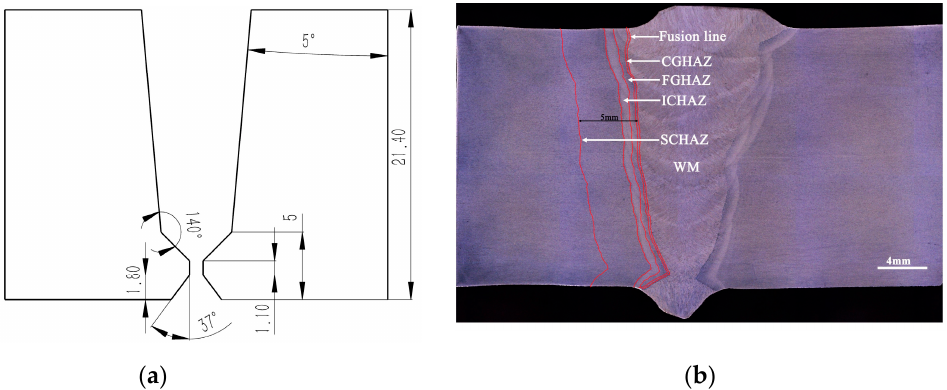
Figure 1. Macroscopic appearance of the X80 pipeline steel ‐ welded joint. ( a ) welding groove structure; ( b ) cross ‐ section of the weld joint.